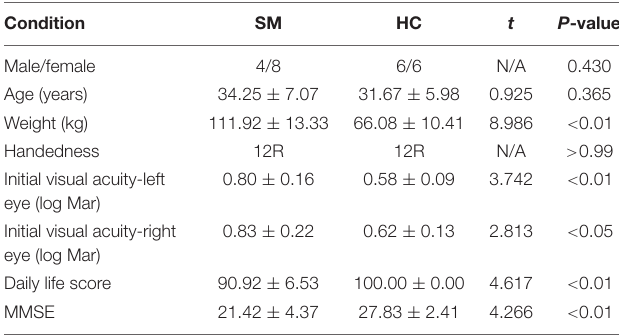
TABLE 1 | Basic information of participants in the